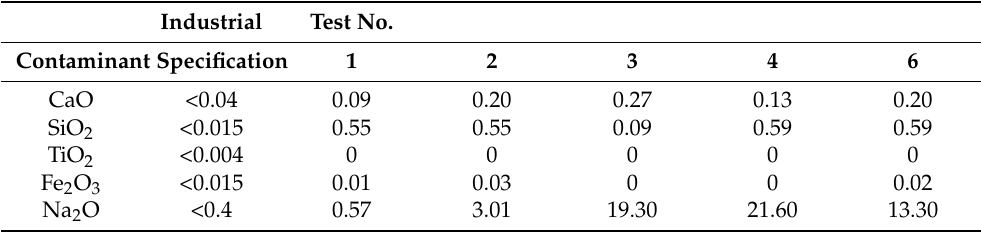
Table 11. XRF analysis of major contaminants in precipitation filter cake (wt%). Industrial Test No. Contaminant Specification